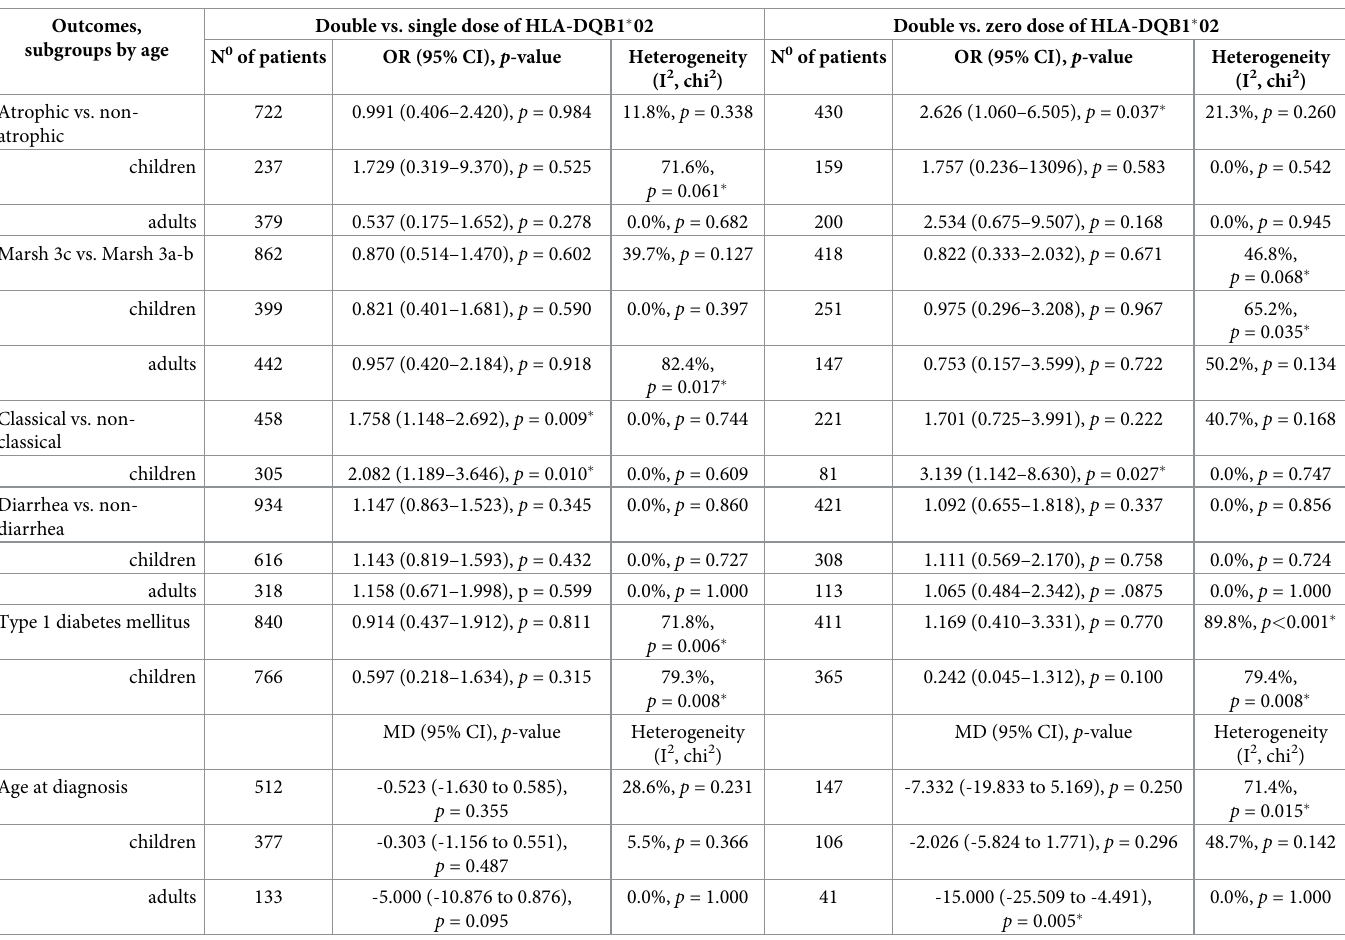
Table 2. Results of